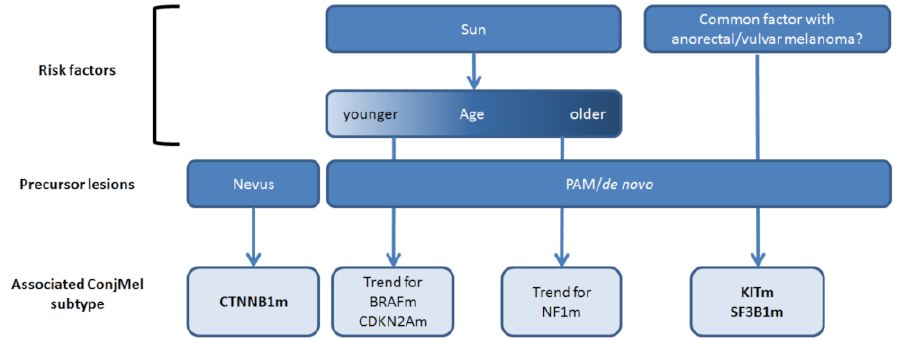
Figure 3. Proposal of molecular classification according to potential etiological